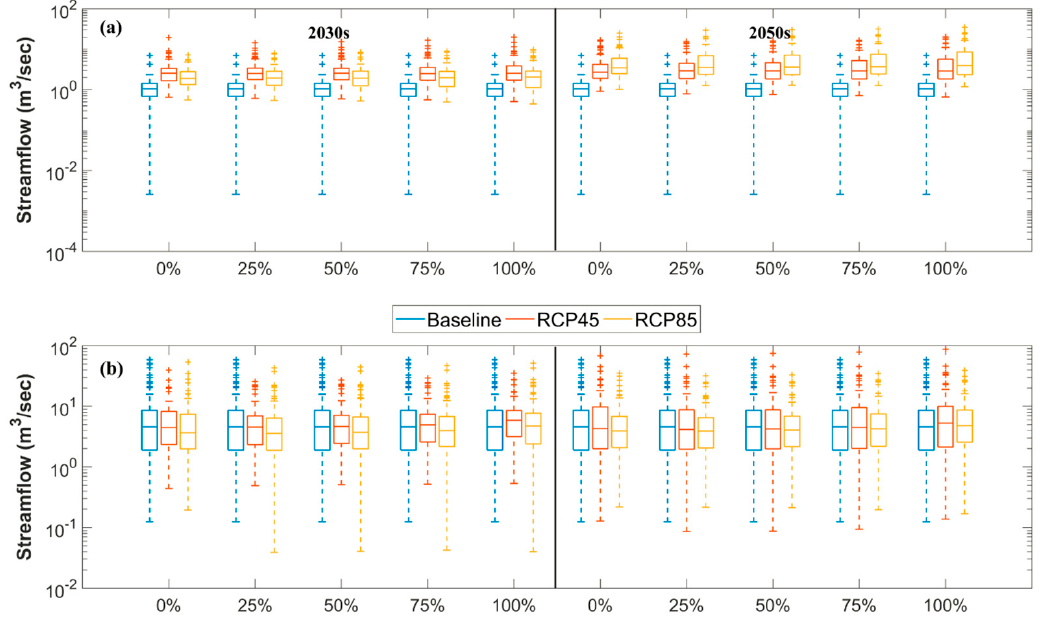
Figure 8. Seasonal streamflow boxplots for ( a ) winter (DJF) and ( b ) summer (JJA) under RCP 4.5 and 8.5 for all climate and land use change scenarios at the catchment outlet (WSC ID: 05MD004) relative to the baseline period. The numbers labeled as percentages indicate pothole wetlands removal.